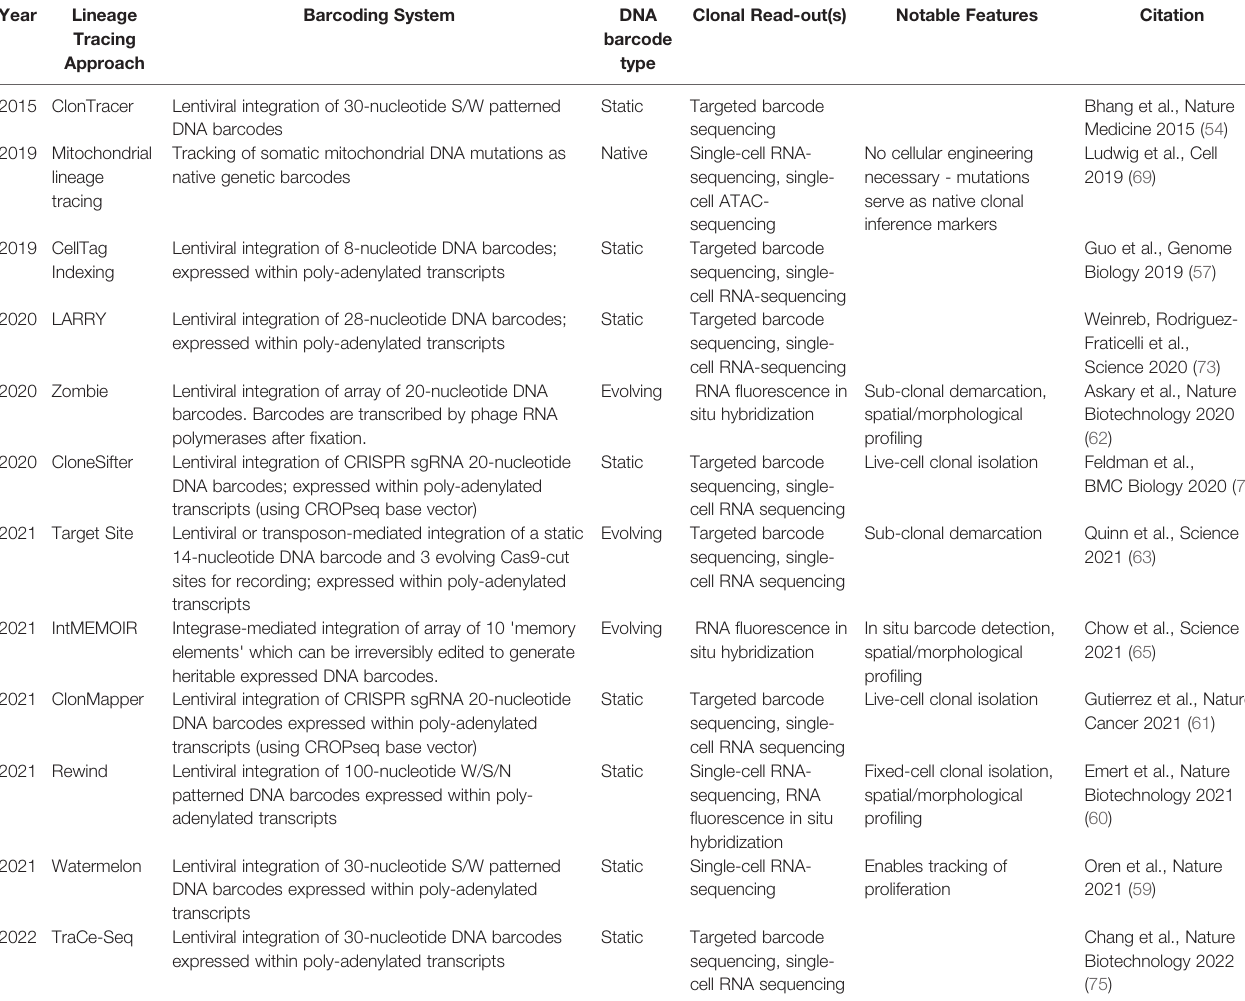
TABLE 1 | Examples of Lineage Tracing Approaches and Their